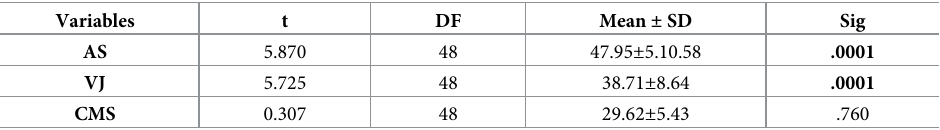
Table 2. The inferential analysis of the pairwise comparison between the HPA and LPA.